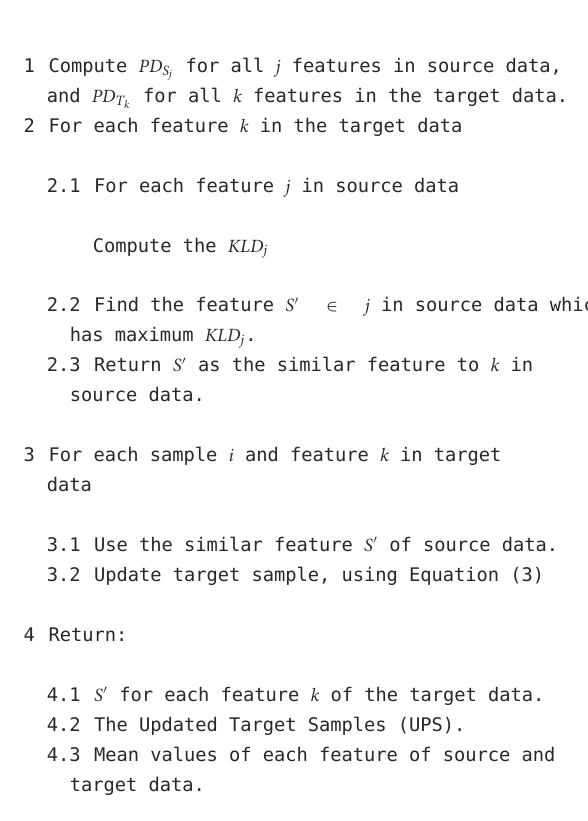
Algorithm 1. Transfer from Source to Target